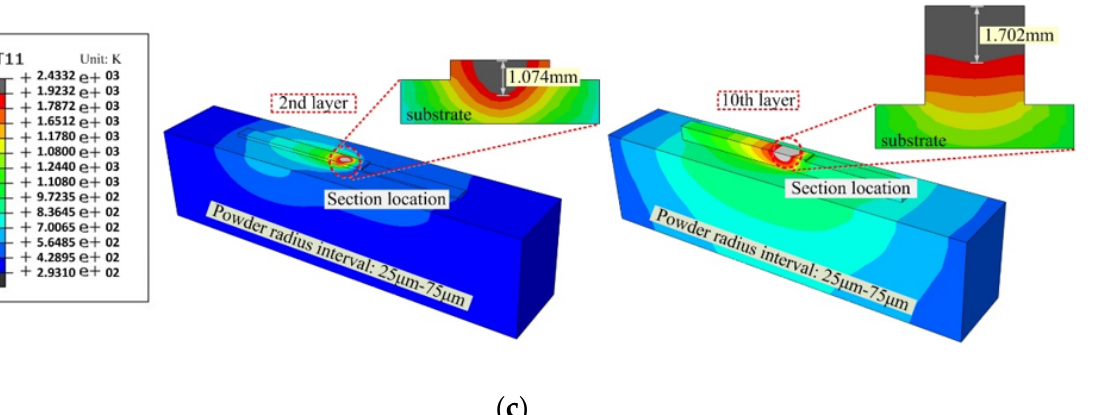
Figure 2. Integration of powders with double ellipsoid heat source model [59,65]: ( a ) powder flows; ( b ) temperature rises of powders; and ( c ) temperature rises in additive manufacturing. (Reprinted/adapted with permission from Refs. [59,65]. Elsevier, 2020; Elsevier, 2022).